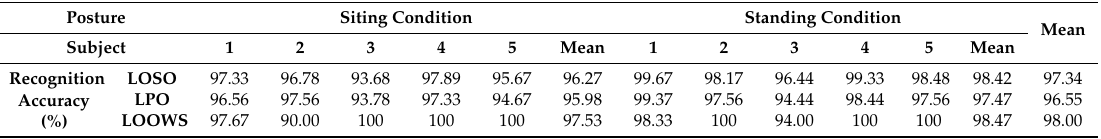
Table 4. Gesture recognition accuracies using three cross-validation methods with five subjects.